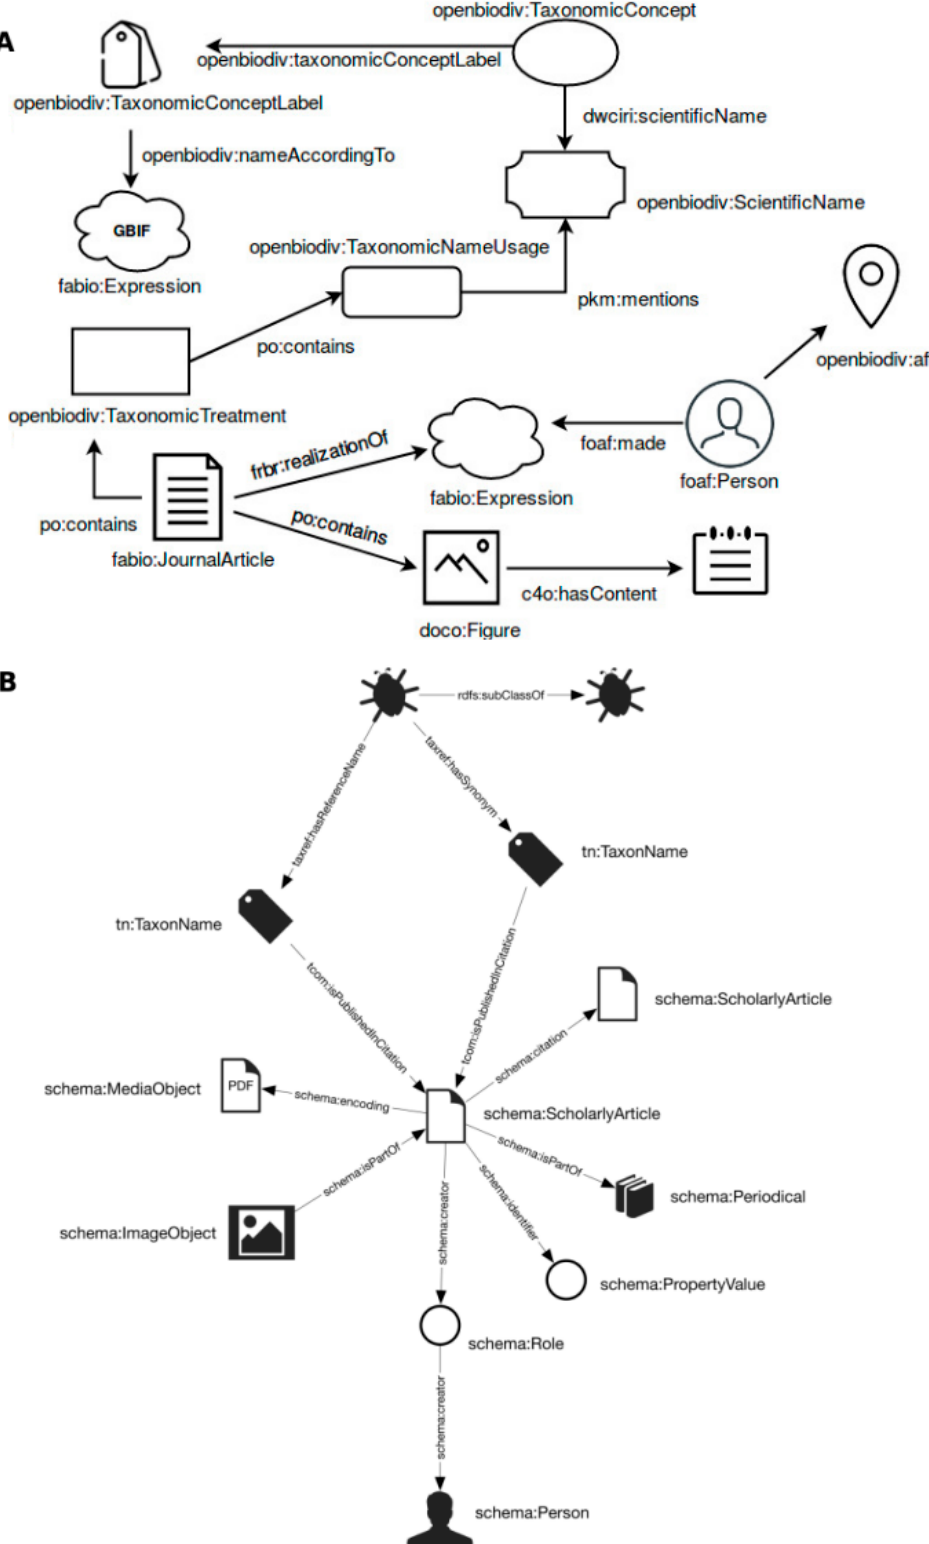
Figure 3. Conceptual modelling of a taxonomic article in OpenBiodiv ( A ) and Ozymandias ( B ) (re-used from [27]).